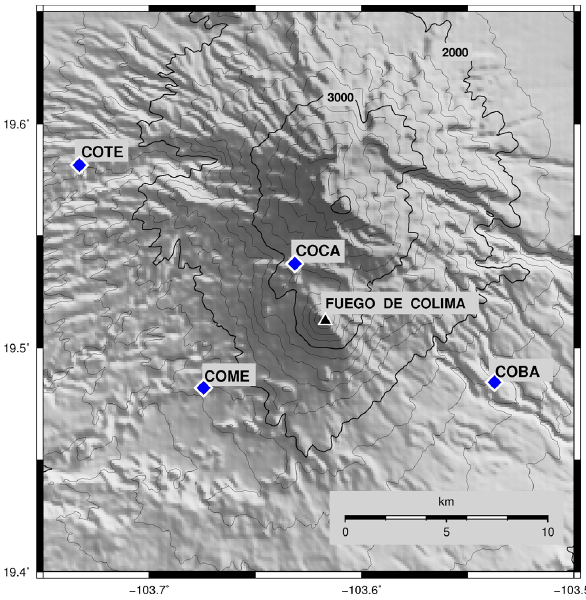
Fig. 10. Position of the seismic sensors at the Colima volcano. The black triangle indicates the crater